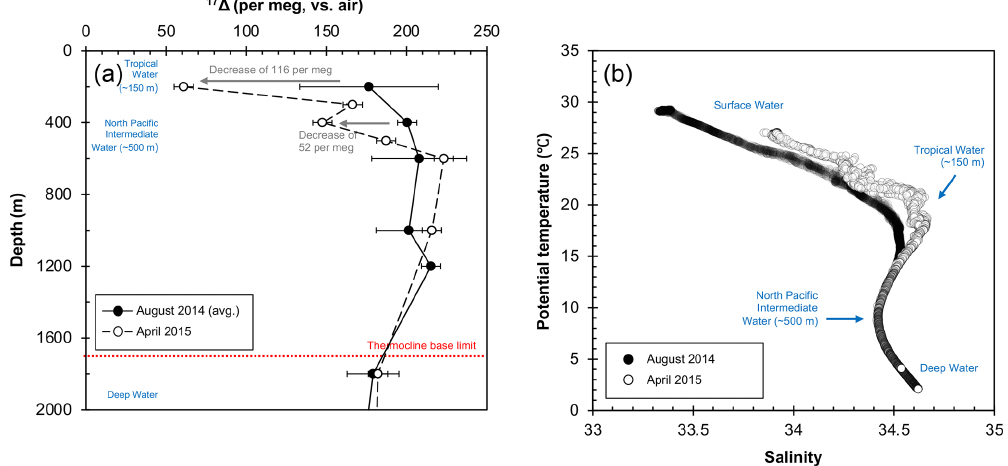
Figure 5. Deep water composition at SEATS from August 2014 to April 2015; (a) 17 (cid:49) of dissolved O 2 . The 17 (cid:49) values from August 2014 are shown as mean of the 2 sampling days (5 and 6 August). Error bars indicate the standard deviation between the 2 collection days (1 σ ) where available or the analytical uncertainty (6 per meg; 1 σ ). (b) Relationship between potential temperature and salinity. Salinity peak of ∼ 34.6 (and ∼ 20 ◦ C) corresponds to the Tropical Water situated around 150m, while the minimum of ∼ 34.4 indicates the North Pacific Intermediate Water at around 500m. The Deep Water below the thermocline base ( ∼ 1700m) is characterized by low temperatures of ∼ 2 ◦ C and high salinities around ∼